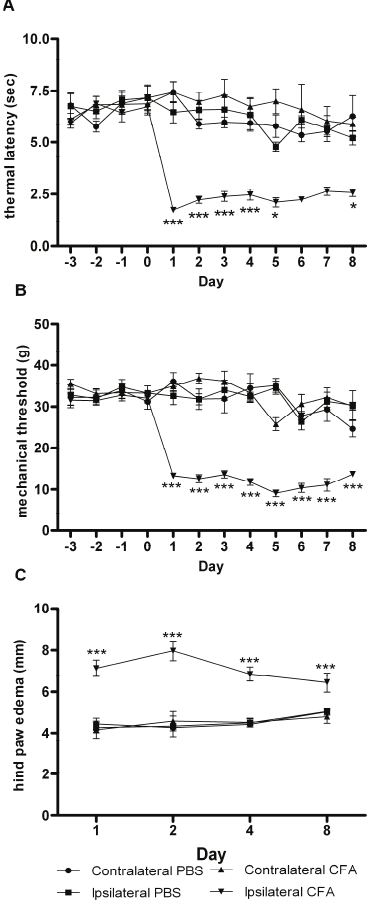
Figure 1. Thermal latencies, mechanical thresholds, and metatarsal thicknesses from rat hind paws after injection with phosphate buffered saline (PBS) or complete Freund’s adjuvant (CFA).